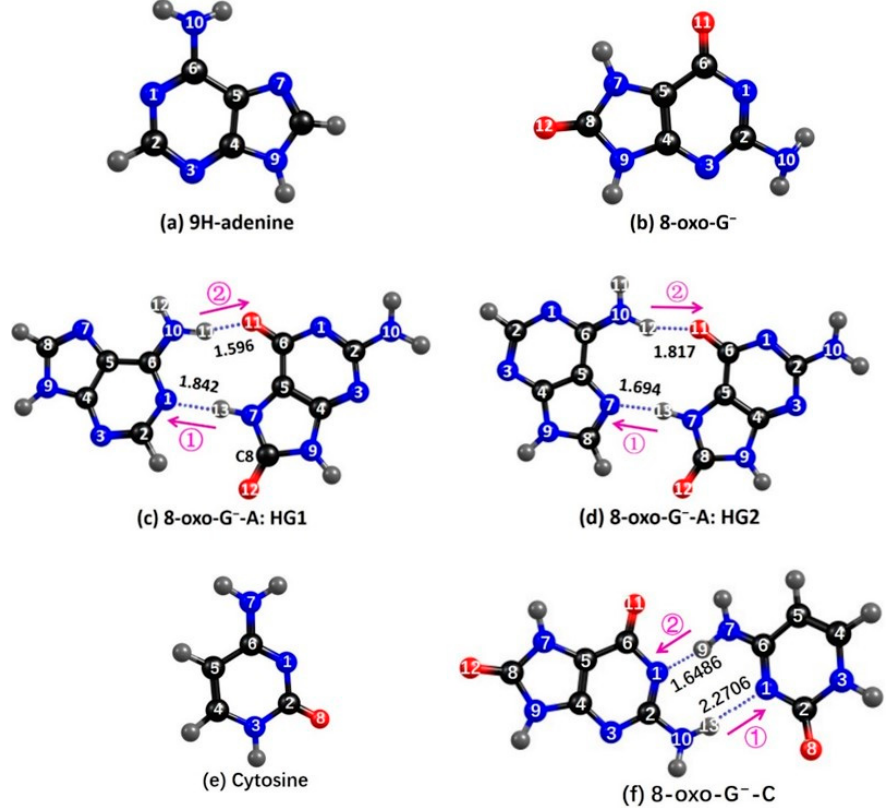
Figure 1. Ground-state equilibrium geometry of ( a ) isolated 9 H -adenine; ( b ) isolated 8-oxo-G − ; ( c ) HG1 form of 8-oxo-G — A; ( d ) HG2 form of 8-oxo-G — A; ( e ) isolated cytosine; and ( f ) 8-oxo-G − -C.